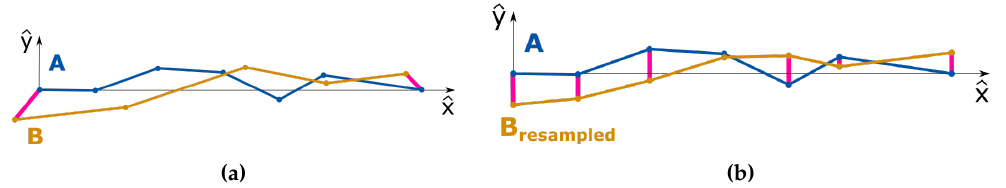
Figure 8. Uncertainties in LKF localization. ( a ) Endpoint deviation = average of the lengths of the two magenta lines connecting the endpoints of lines A and B ; ( b ) Contributions to the localization error (magenta lines). Since A and B are sampled at different ( ˆ x , ˆ y ) -positions, line B is interpolated at the ˆ x -positions of line A . The interpolated line is denoted B resampled in the figure.